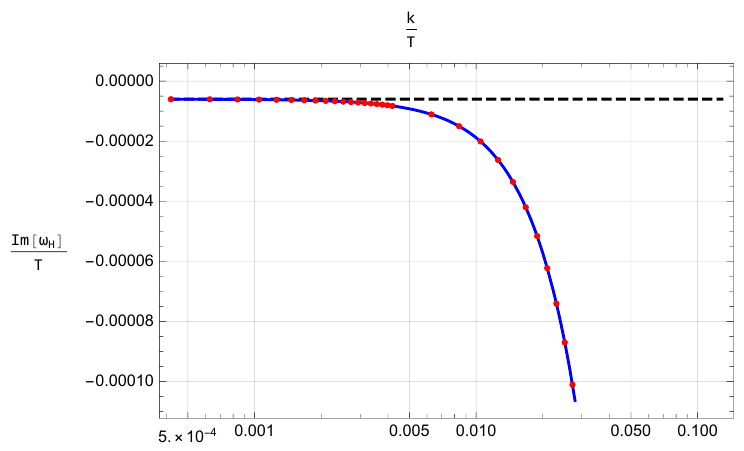
Figure 3 . Plot of ω H as a function of k for φ ( s ) c = 0 . 999999519 . The dots are the numerical results T φ ( s ) and the solid line is the analytic result. The dashed horizontal line marks the analytic prediction for the gap of the Higgs mode.